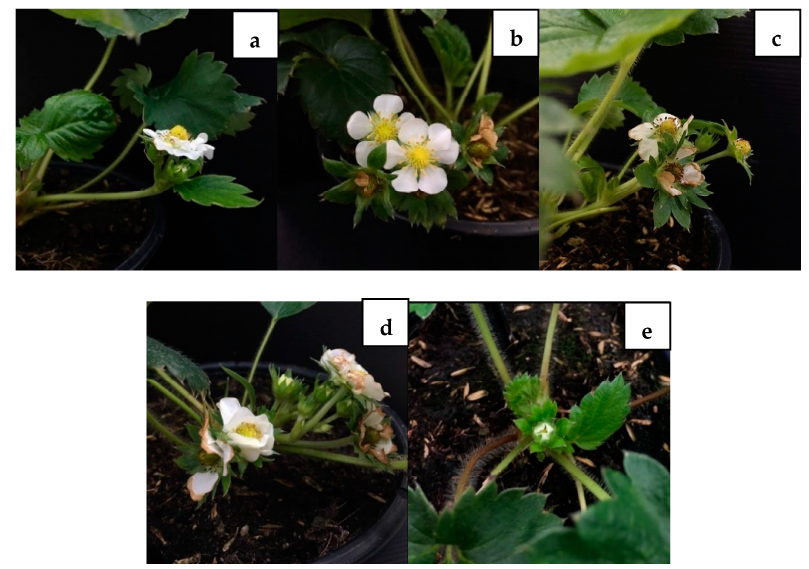
Figure 1. Inflorescence of strawberry cv. Pharachatan 80. ( a ) After 4 weeks of vernalization at 4 °C for 1 week. ( b ) After 4 weeks of vernalization at 4 °C for 2 weeks. ( c ) After 4 weeks of vernalization at 2 °C for 1 week. ( d ) After 4 weeks of vernalization at 2 °C for 2 weeks. ( e ) After planting for 8 weeks (control).